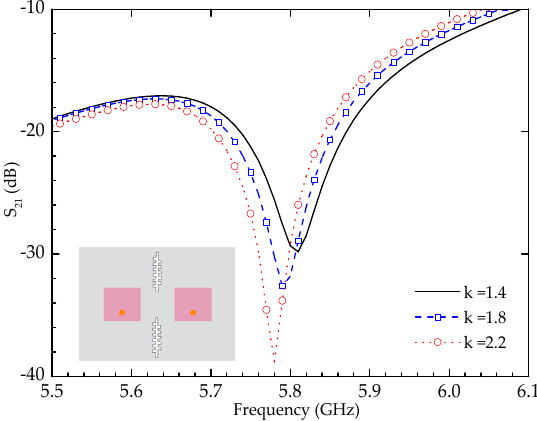
Figure 7. S 21 on different k at 5.8 GHz where b = 0.7 and c = 2.29 (unit, mm).